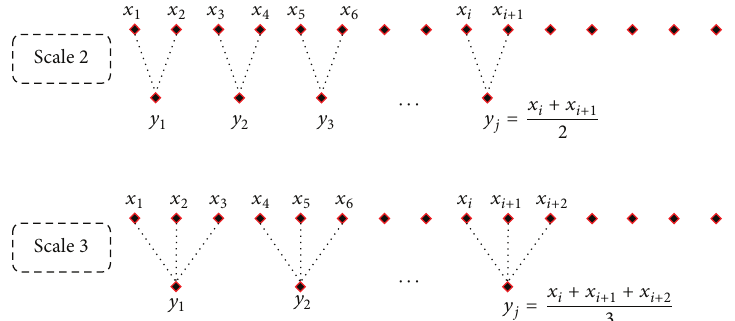
Figure 3: A schematic illustration of the coarse-graining